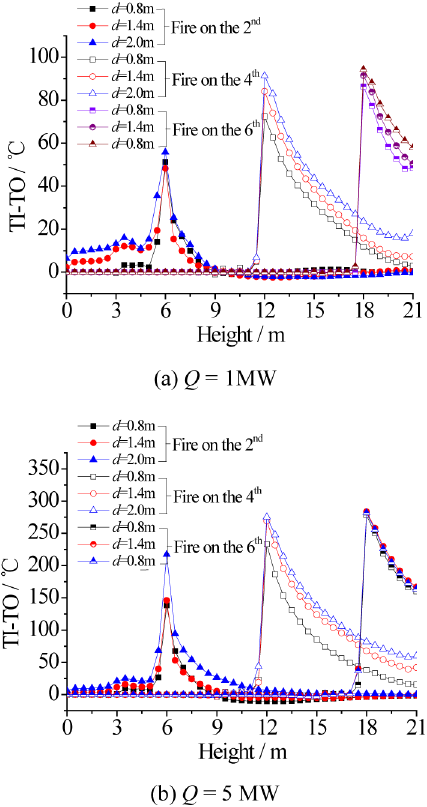
Fig. 9. Curves of TI-TO with the cavity depths of 0.8 m, 1.4 m and 2.0 m